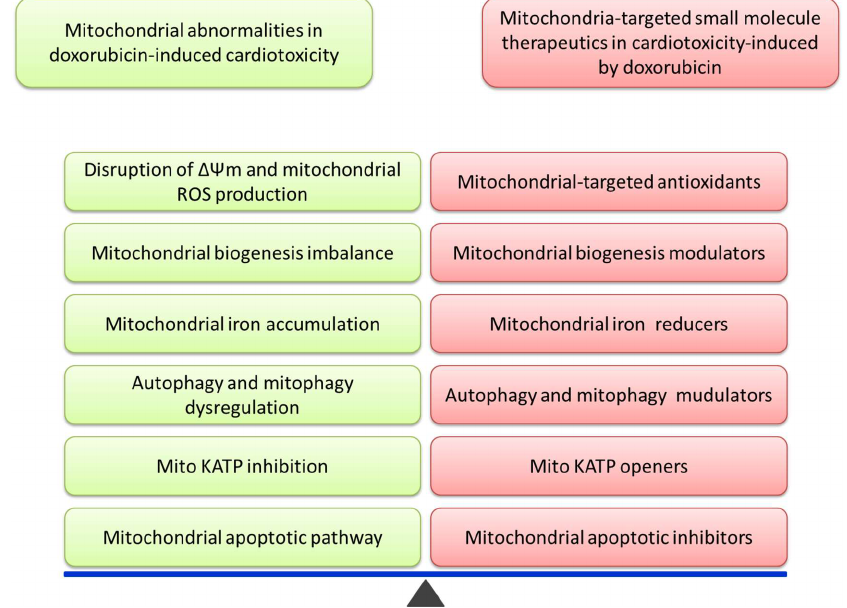
Figure 1. This image shows that establishing mitochondrial stability by small molecules is a critical step of potential therapeutic mechanisms in Dox-induced cardiotoxicity.